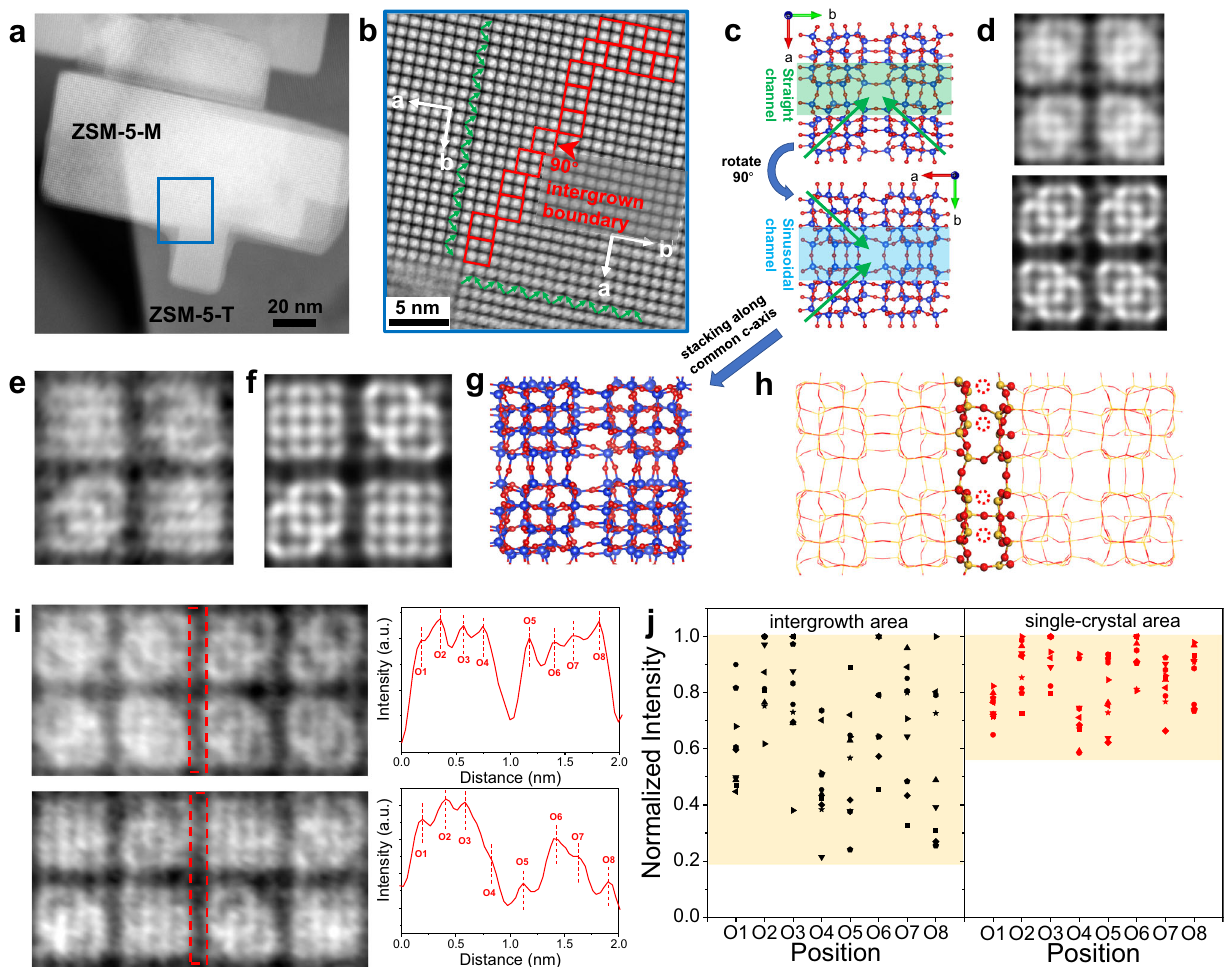
Fig. 2 Atomic interface structures in ZSM-5-MT catalyst. a ADF-STEM image of ZSM-5-MT from the [001] projection. b Magni fi ed iDPC-STEM image of intergrowth interface in the area marked by the blue frame in ( a ). The intergrowth area between mortise and tenon is marked by red frames. c Structural models of ZSM-5 from the [001] projection. d Magni fi ed iDPC-STEM image (top) and simulated iDPC-STEM image of ZSM-5 lattice in a pure mortise or tenon area (bottom) from the [001] projection. e - g Magni fi ed iDPC-STEM image, simulated iDPC-STEM image and structural model of overlapped lattices in the intergrowth area by stacking two models in ( c ) along the c -axis of ZSM-5. h Structural model of the interface in ZSM-5-MT showing the partial missing of O atoms due to the slight lattice mismatch. i Magni fi ed iDPC-STEM images of single-crystal (top) and intergrowth (bottom) areas from the [001] projection and corresponding intensity pro fi les. Eight positions and intensities of eight O atom columns can be identi fi ed in each pro fi le. j Statistical results of the normalized intensities of O peaks in single-crystal (red symbol) and intergrowth (black symbol) areas. In statistics, 10 data are included for each area and different shapes of symbols are corresponding to the data in different pro fi les (Supplementary Figs. 12 – Fig. 10, the missing of O atoms in columns is accompanied by the